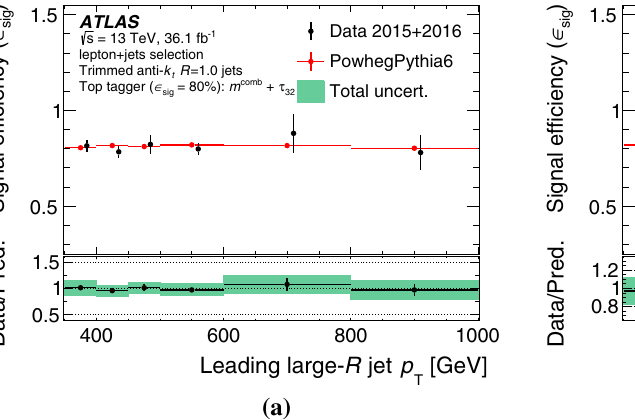
in data to that estimated in Monte Carlo is shown with statistical uncer- tainties as error bars on the data points and the sum in quadratre of statistical and systematic uncertainties as a shaded band. When consid- ering experimental uncertainties arising from the large- R jet, only those coming from the jet energy scale and resolution are considered